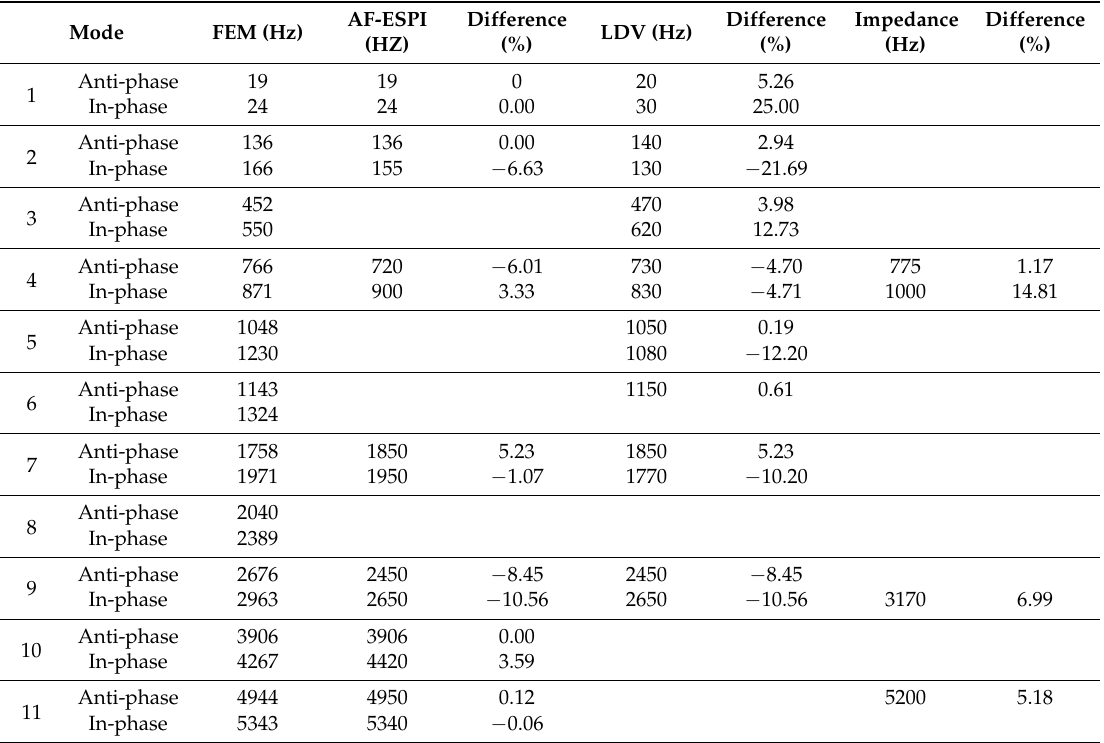
Table 5. Resonant frequencies of piezoelectric valveless micropumping element under glycerine-coupled